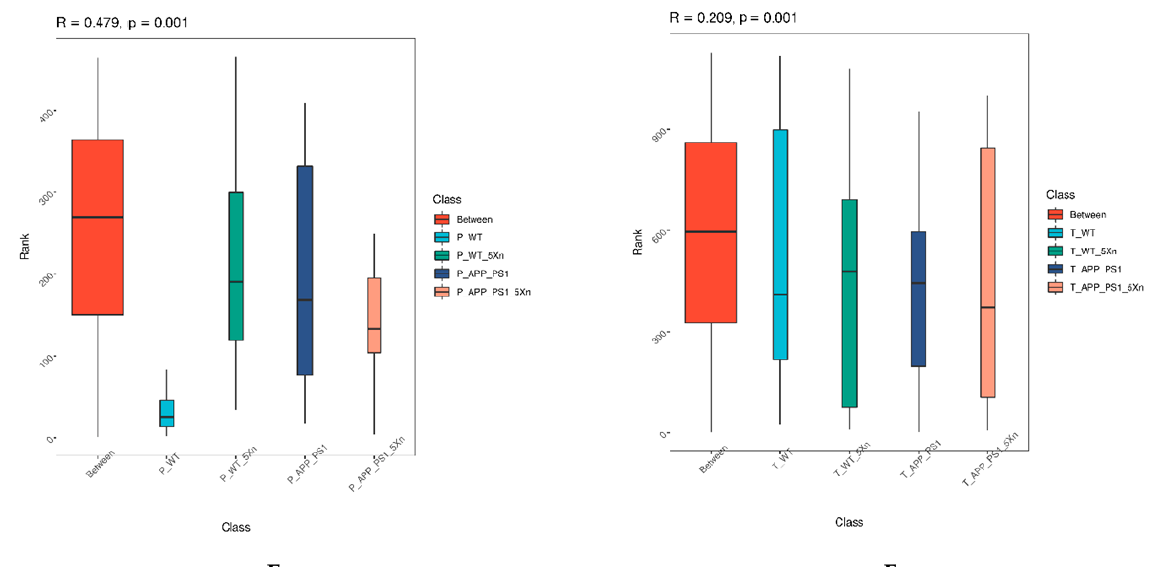
Figure 2. Diversity analysis among groups in the prevention and therapy experiment of Xn. ( A , B ) Ace index of α diversity analysis depicting the difference in microflora abundance among groups. The differences were analyzed by Tukey test or Kruskal-Wallis test–a, b represent significant difference between them; ab represents no difference with a or b. ( C , D ) Principal co-ordinates analysis (PCoA) of β diversity analysis depicting the difference in microflora composition among groups. The differences were analyzed by Adonis multivariate analysis of variance based on unweighted Unifrac algorithm. Each dot represents a sample, and each color represents a different grouping. The closer the two samples are, the more similar their species composition is. The horizontal and vertical coordinates represent the two principal coordinates that contribute most to the group difference. The larger the R 2 , the higher the explanation of the difference. ( E , F ) Anosim test used to judge whether the grouping is meaningful. R-value is between ( − 1, 1), and R-value is greater than 0, indicating that the difference between groups is greater than the difference within groups. R-value is less than 0, indicating that the difference within groups is greater than the difference between groups. The p value less than 0.05 indicates significant.